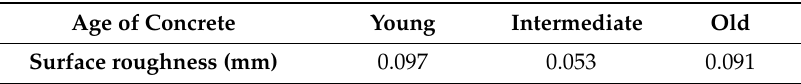
Table 2. Surface roughness values for each type of concrete used.